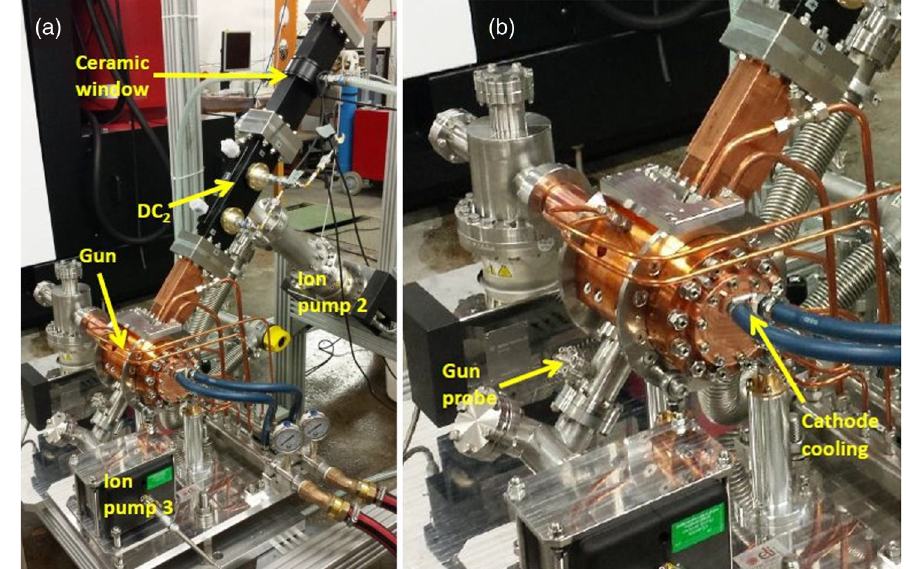
FIG. 20. Detailed pictures of the rf gun under the high power